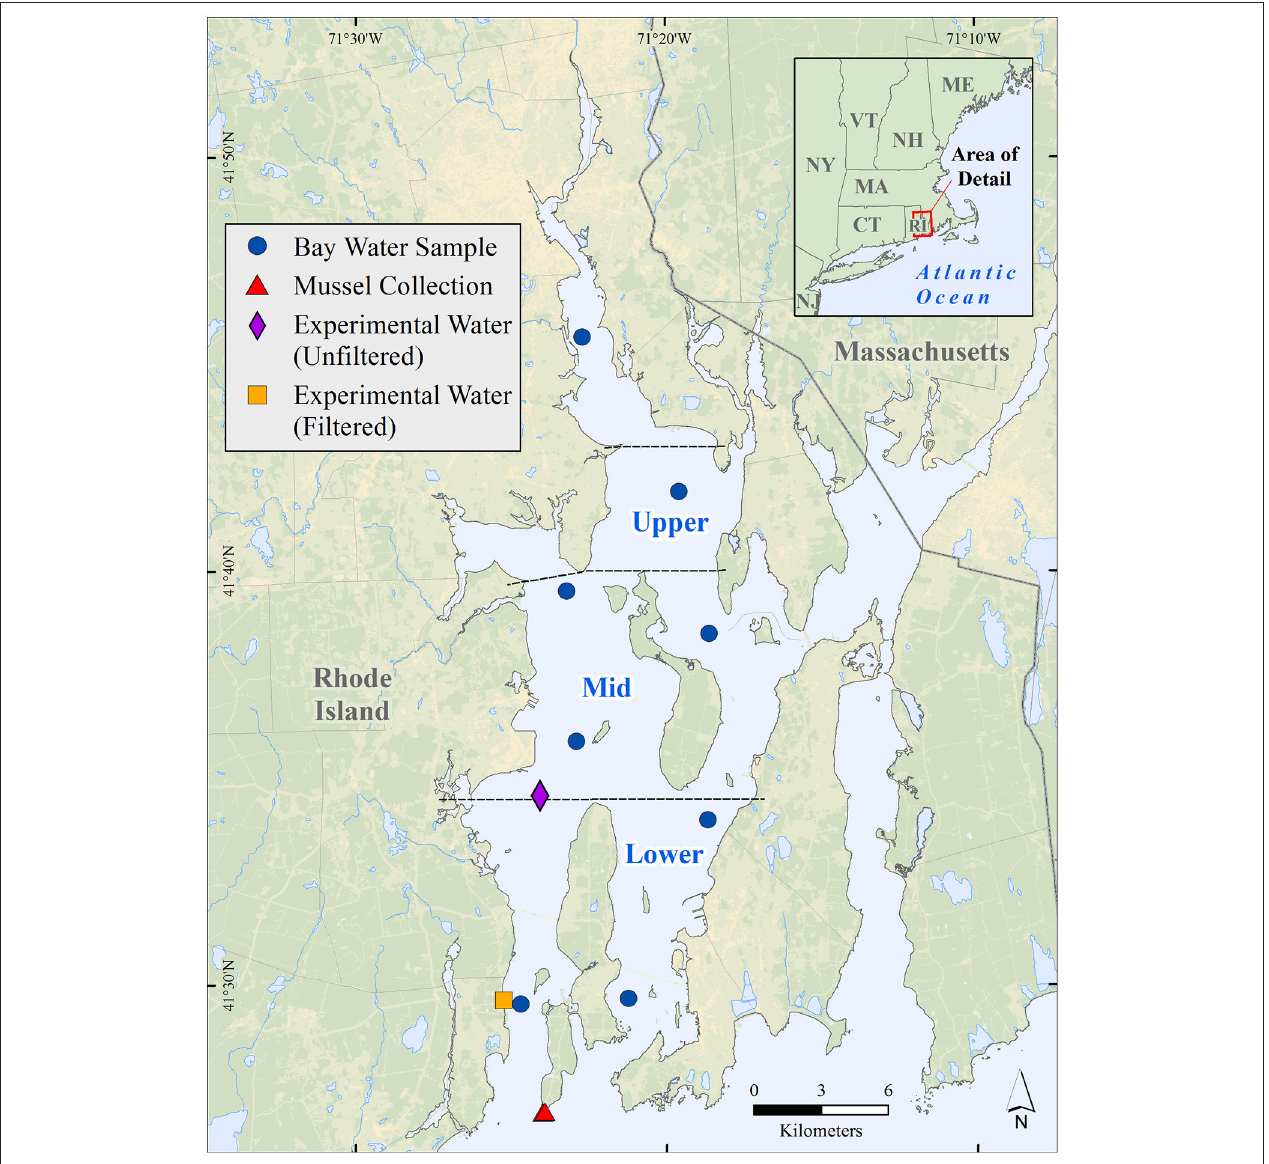
FIGURE 2 | Map of Narragansett Bay (RI, USA) showing station locations for water samples collected from the top, middle, and bottom of the water column at each of eight locations as well as the locations where the mussels and water were collected for use in the Ecostat experiments. Water quality data from December 2014 and December 2015 from the eight stations were grouped by spatial category and incorporated into an empirical model (results presented in Figures 6 , 7 ). The boundaries of our regional groupings are delineated with the dashed lines. The Providence River Estuary is north of the Upper Bay